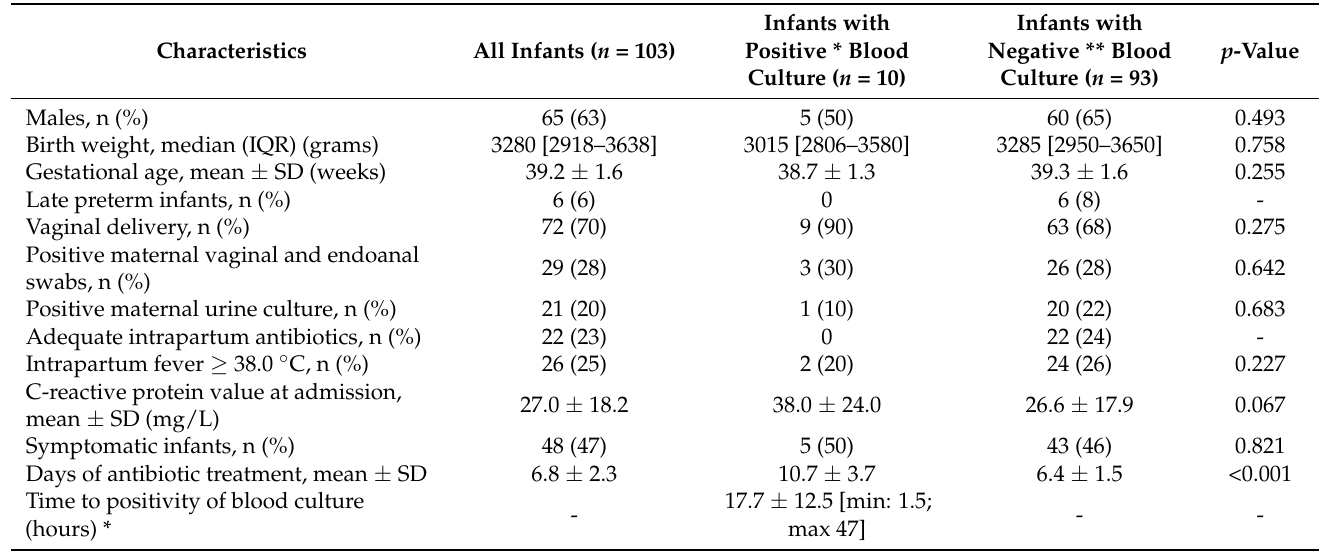
Table 1. Characteristics of newborns with suspected early-onset sepsis. Data are presented as numbers (%) for categorical variables (compared with Fisher test), mean ± SD or median (IQR) for continuous variables (compared with t -test or Mann-Whitney test as appropriate, respectively) as depending on the distribution of the